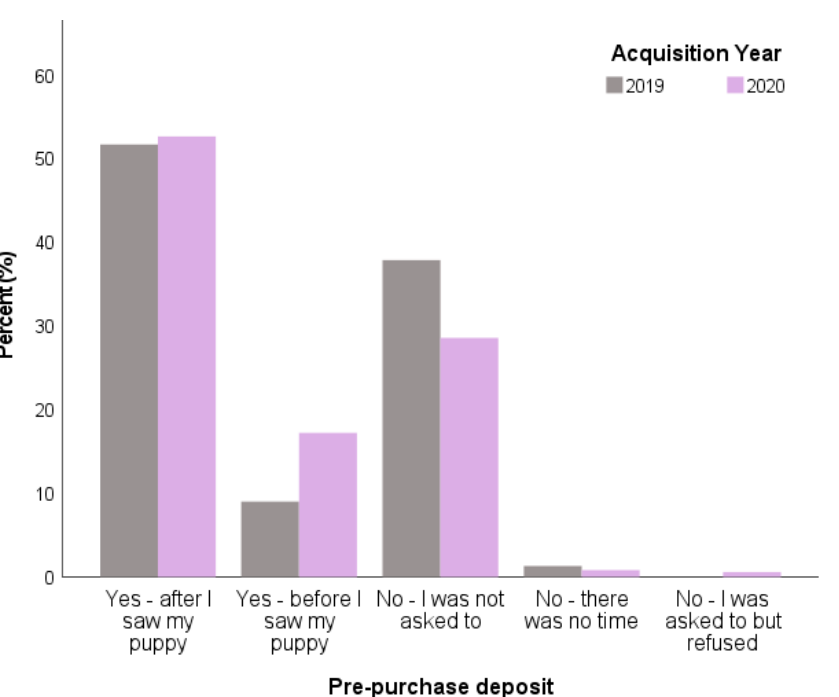
Figure 5. Deposit practices to secure puppies prior to purchase ( n = 4463) with comparison between